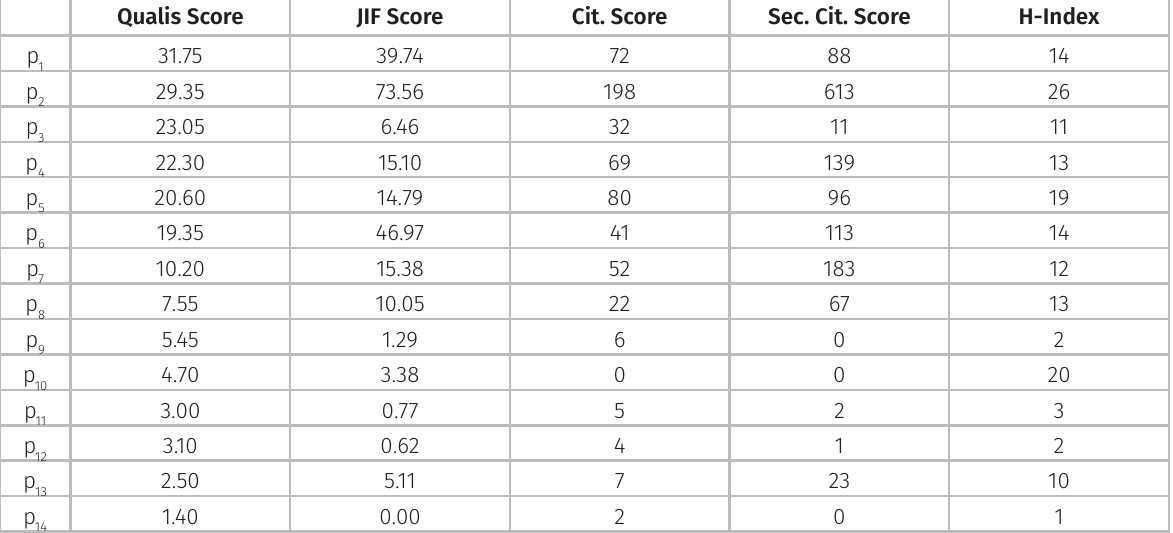
Table II. Input data for professor metrics from graduate program rated 6 out of 7 from 2015 to 2018, cumulative score history and H-Index until